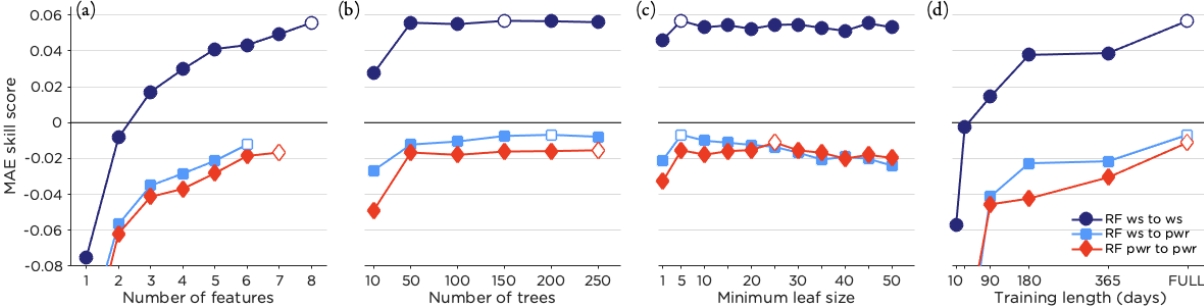
Figure 6. MAE skill score for the optimization period for the three RF setups tested. In panel (a) the improvement of MAE skill score when training features were added according to the order in Table 2 is shown. Panels (b) , (c) and (d) show how the MAE skill score was affected by changing the number of trees (using the best set of features), the MLS (for the best set of features and optimal number of trees) and the training length (for optimal selection of features, number of trees and MLS). The optimal setting for each setup is marked in white. Note that the values for MAE skill score presented here are not directly comparable to the MAE skill scores presented in other figures in this paper as these are for the optimization and not the test period.